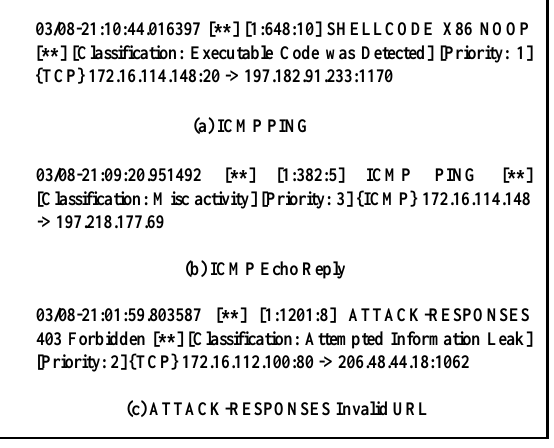
Figure 2. Examples of Snort alarms. Fig. 2. Instances of Snort alarms.